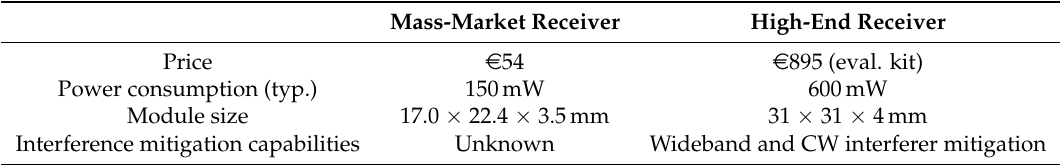
Table 2. COTS receivers used in the experimental